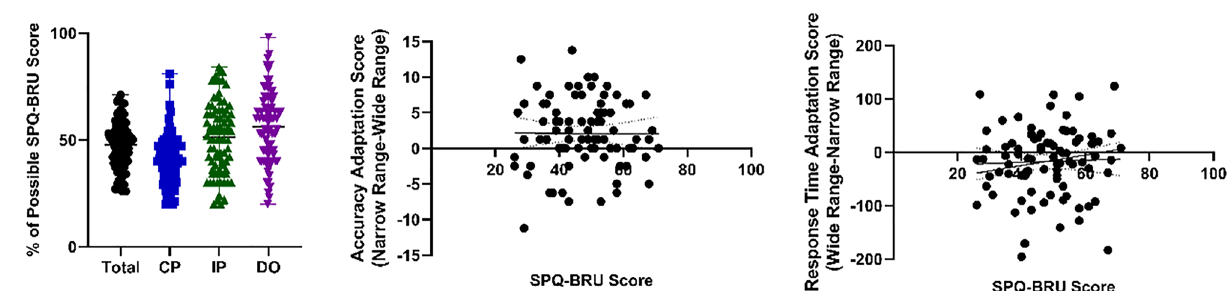
Figure 7. SPQ-BRU scores and correlation with accuracy and response time adaptation scores. We pooled the SPQ-BRU (schizotypal personality questionnaire—brief revised updated) scores of the participants in all three experiments. We display both total scores as well as the sub-scale scores ( CP cognitive perceptual, IP interpersonal, DO disorganized). The scatter plots illustrate the relation of total SPQ-BRU score with the accuracy and response time adaptation scores (higher levels in both adaptation scores reflect stronger adaptation to the narrow compared to the wide